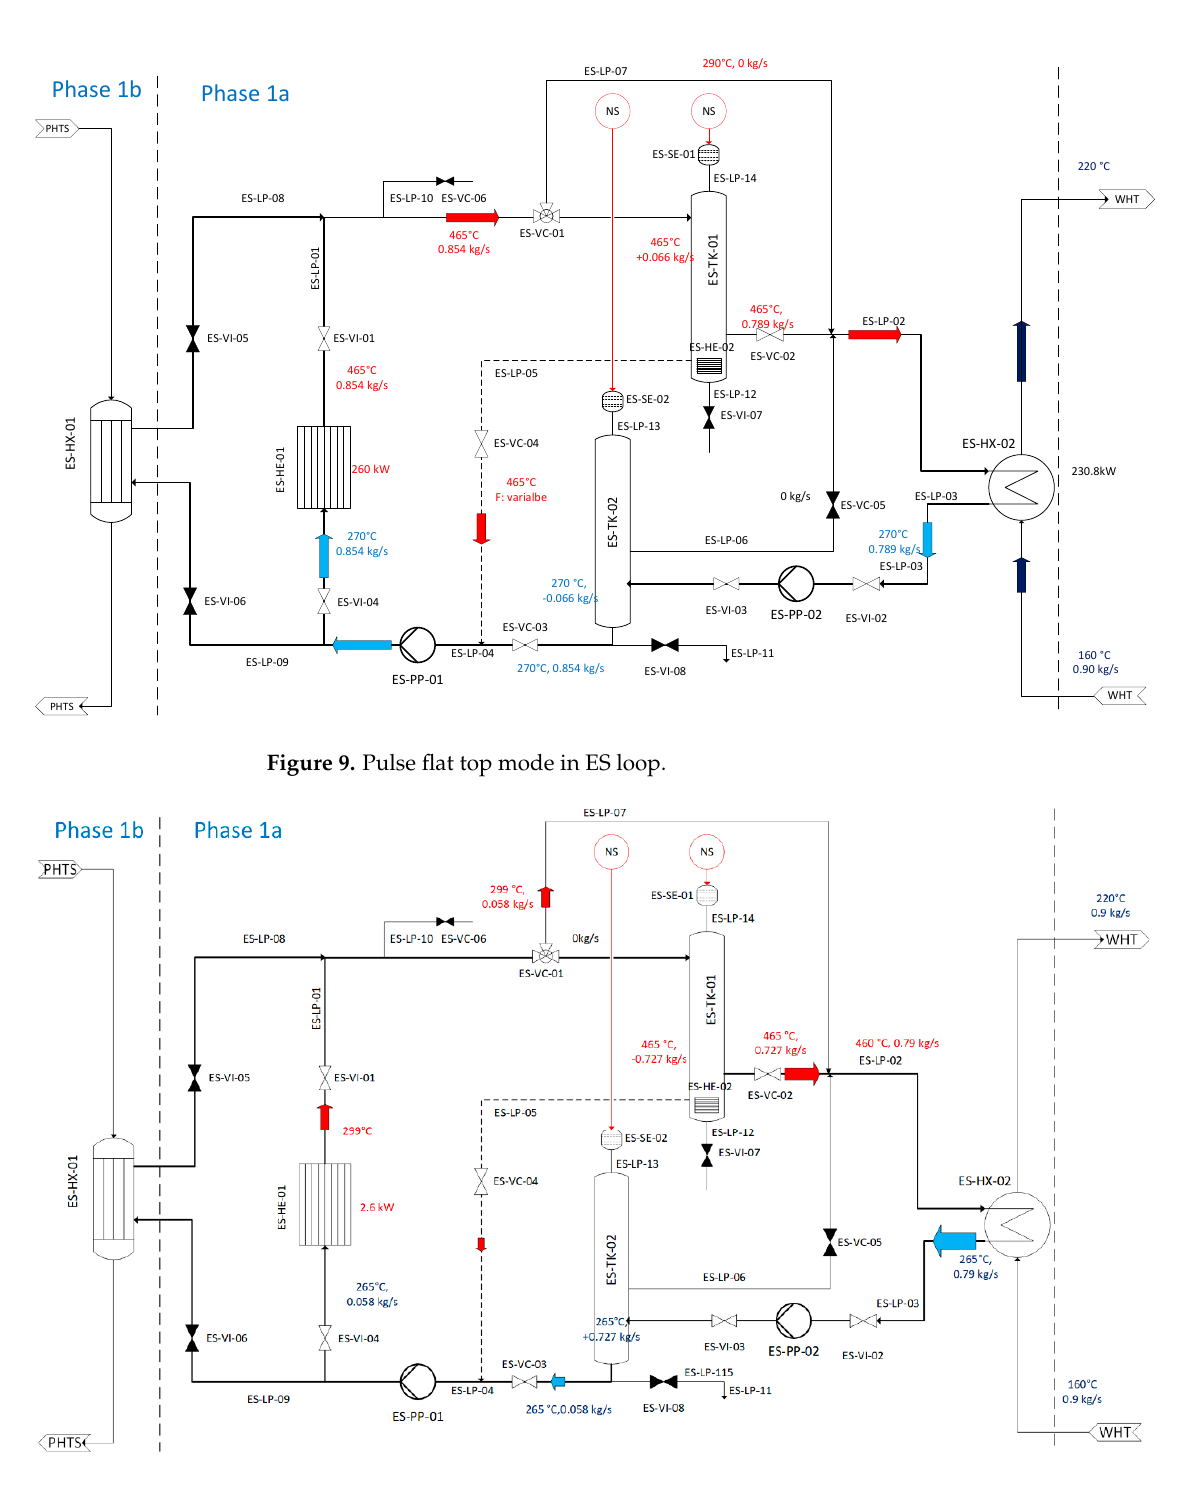
9 Pulse flat top: ES-HE-01 simulates the heat source of the helium with 260 kW. The bypass ES-LP-05 with the valve ES-VC-04 regulates the precise demand on the MS inlet